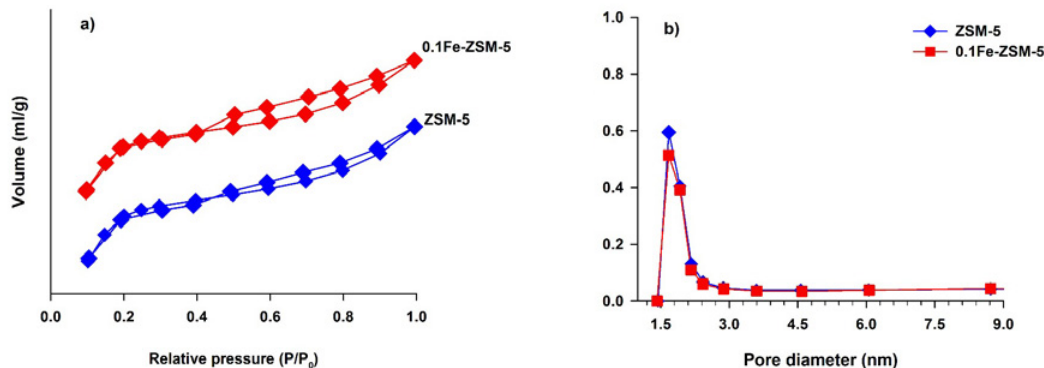
a b Fig. 3. TEM image of the a) HZSM-5 and b) 0.1Fe-ZSM-5